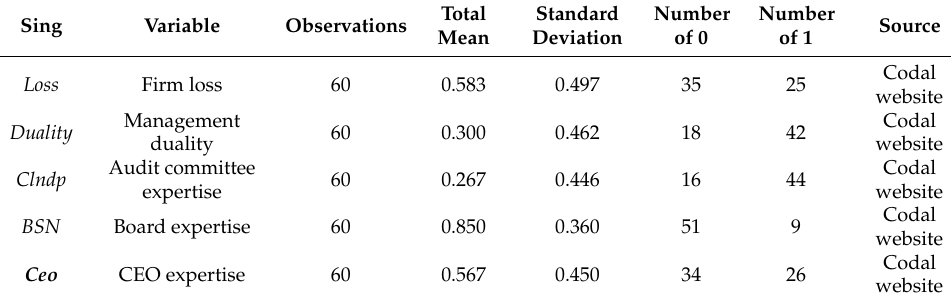
Table 2. Descriptive statistics of qualitative research